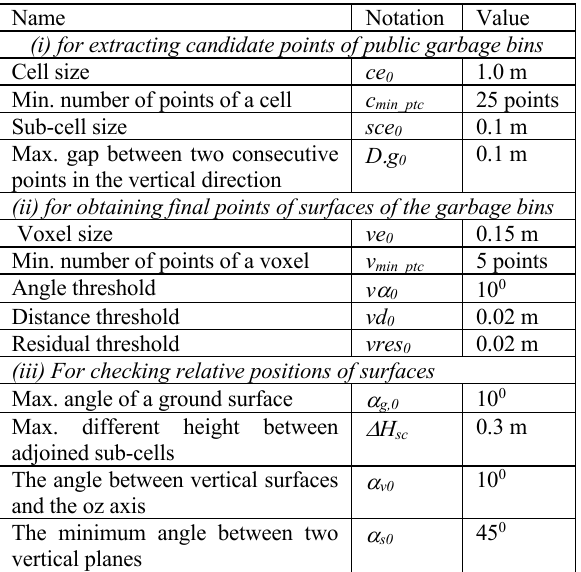
Table 1. Input parameters used in the proposed